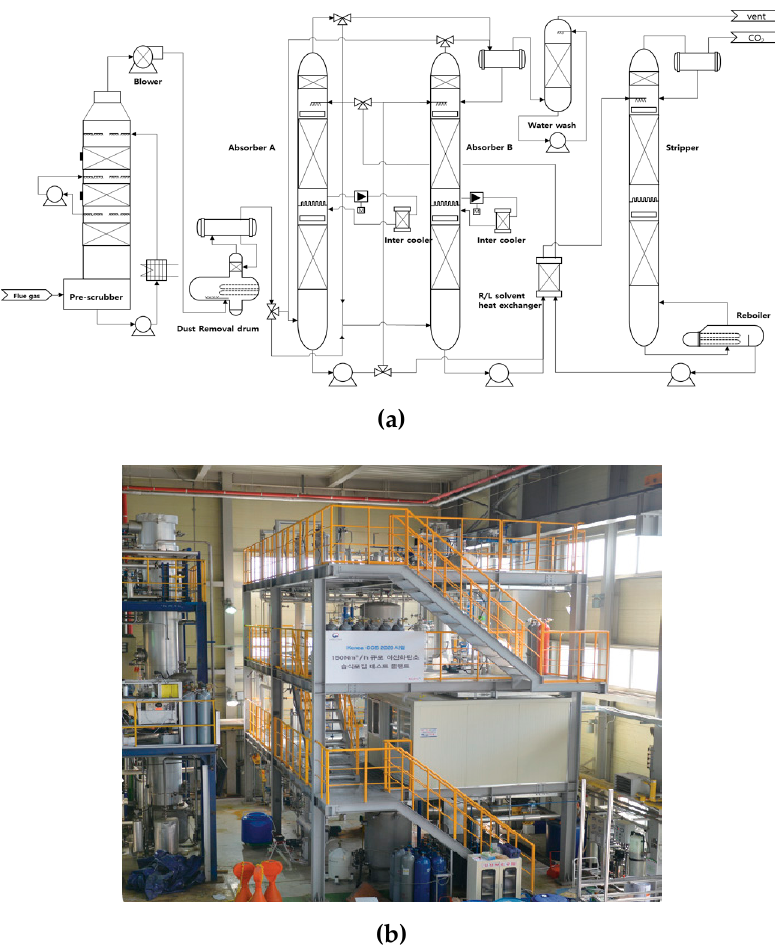
Figure 3. ( a ) Process flow diagram and ( b ) photograph of the PCCP(Pilot CO 2 Capture Process).